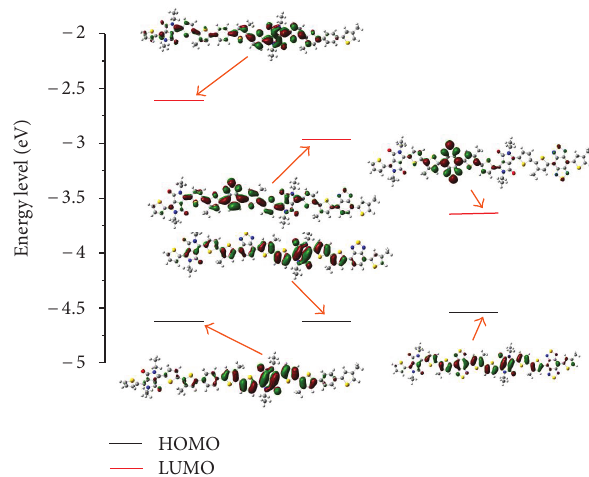
F 2: e energy levels and the electron density distribution of molecular